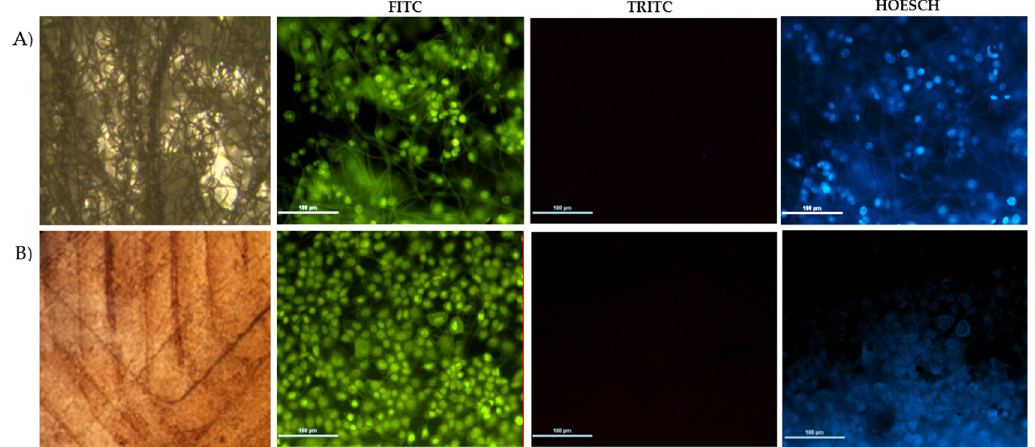
Figure 5. Biocompatibility of HaCaT Cells in scaffolds. ( A ) Control (electrospinning), and ( B ) 3D printing without pores.